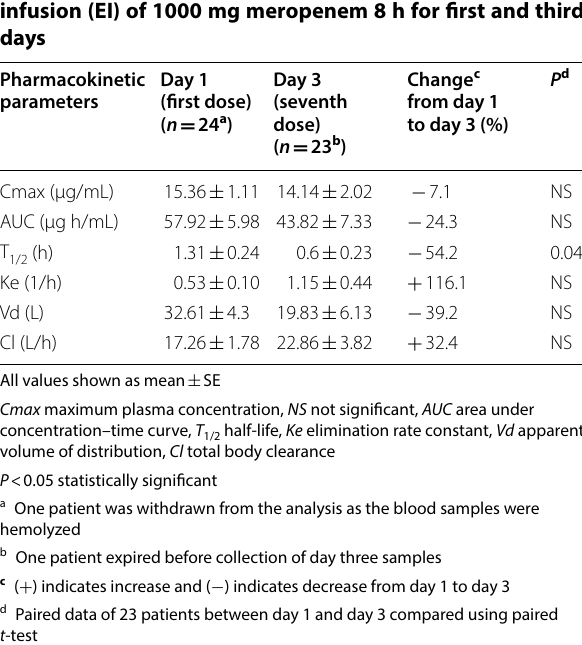
Table 3 Pharmacokinetic parameters after 3-h